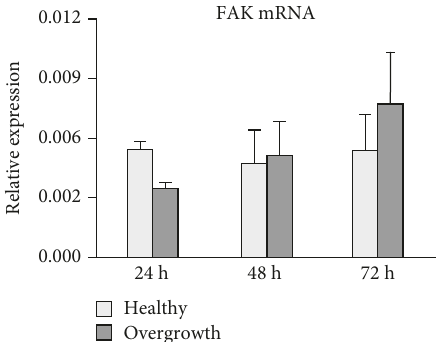
Figure 8: FAK mRNA levels. Bar graphs showing FAK mRNA levels after normalization on GAPDH gene expression. Data are expressed as mean ± SD for samples run in